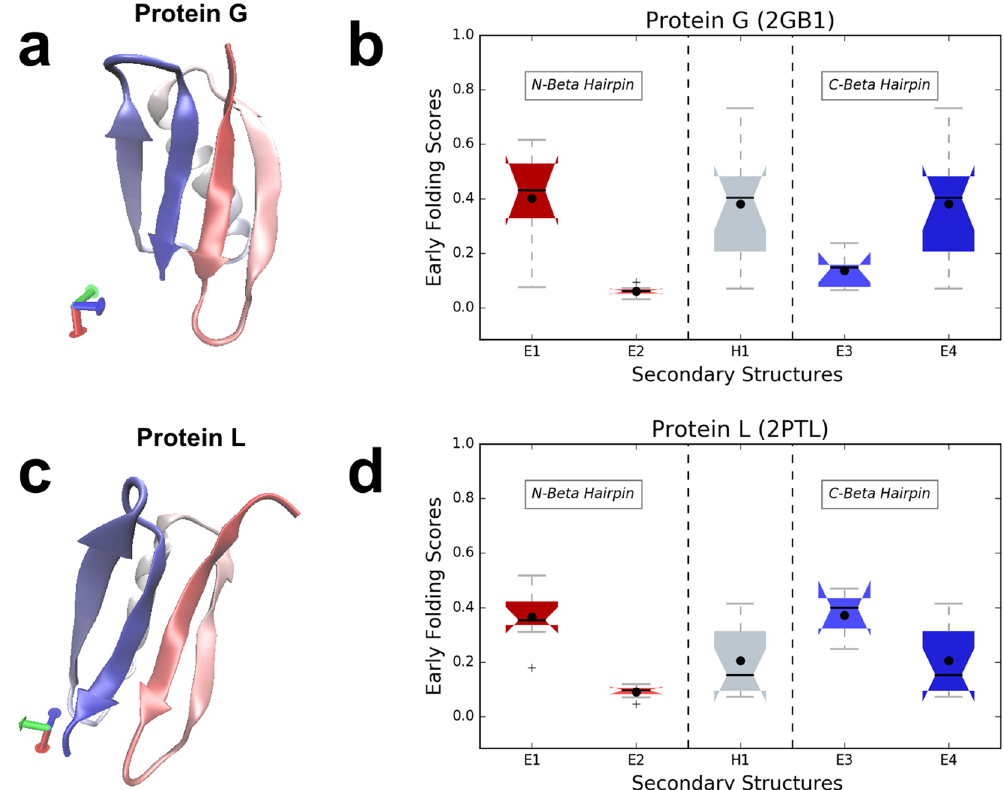
Figure 2. Protein G and L in relation to early folding scores. ( a ) Protein G (PDB:2GB1) with secondary structure elements (E1–E4, H1) indicated, and ( b ) the corresponding distributions of the protein G early folding scores as box plots. ( c ) Protein L (PDB:2PTL) with secondary structure elements (E1-E4, H1) indicated, and ( d ) the corresponding distributions of the protein L early folding scores as box